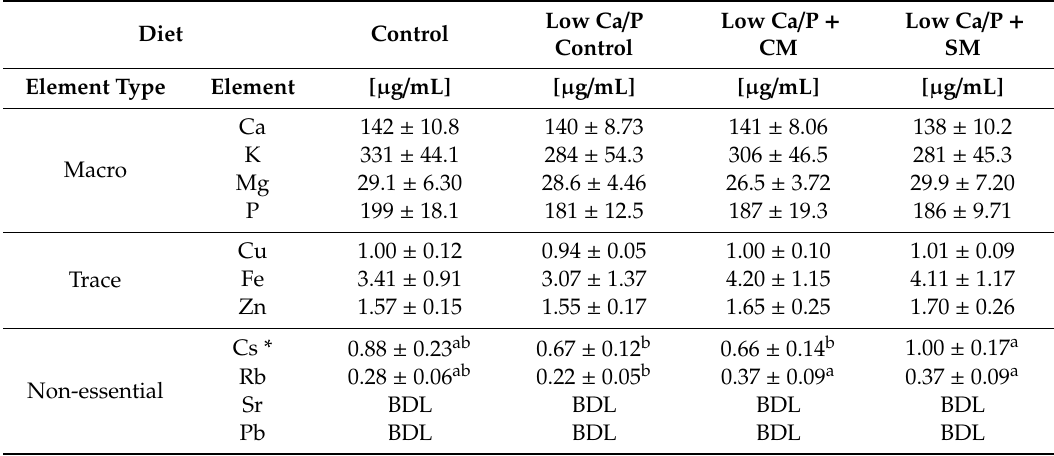
Table 5. Macro, trace, and non-essential mineral concentrations in the serum of rats consuming milk diets ˆ